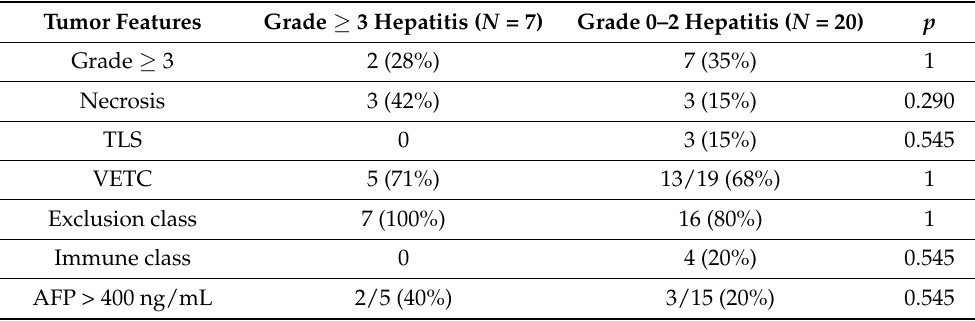
Table 3. HCC morpho-phenotypical features according to the severity of hepatitis. Tumor